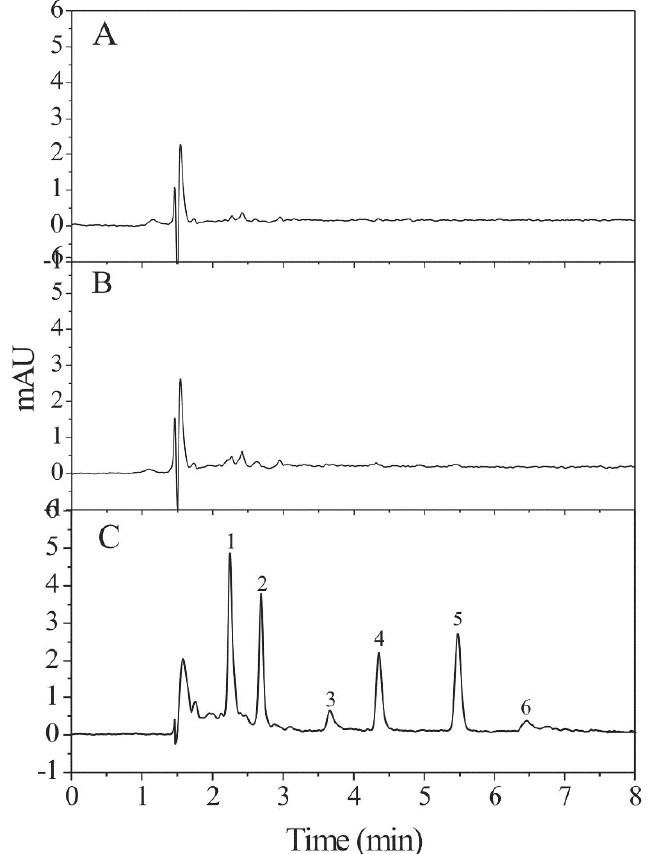
Figure 2. Typical high-performance liquid chromatography-diode array detector (HPLC-DAD) chromatograms of a tomato sauce sample ( A ), a tomato sauce sample, ( B ) a spiked tomato sauce sample ( C ) a spiked tomato sauce sample submitted to the Fe 3 O 4 -NH 2 @MIL-101 m-µ-dSPE procedure. Reprinted from [34] with permission from Elsevier, 2020.